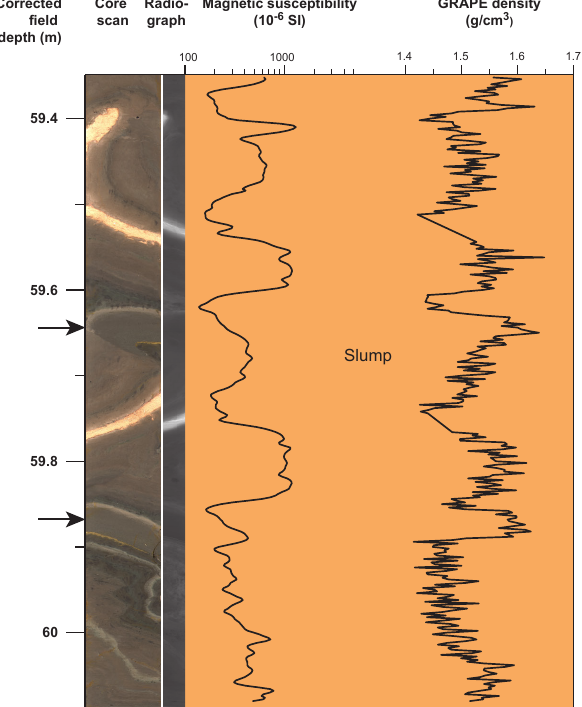
Fig. 6. A 75cm thick section of slump Su128 (age 1.41Ma) in a core scan from 5011-1B-18H-2. This section includes a folded tephra layer (orange in core scan) and a bent turbidite occurring twice (ar- rows). The sediments right above and below the duplicated turbidite (thickness < 3cm) belong to facies A, whereas the remaining sedi- ments belong to facies B. Both magnetic susceptibility and density vary according to the pelagic facies or event layer. Some unusually low density values in the tephra layers were deleted, resulting in gaps in the